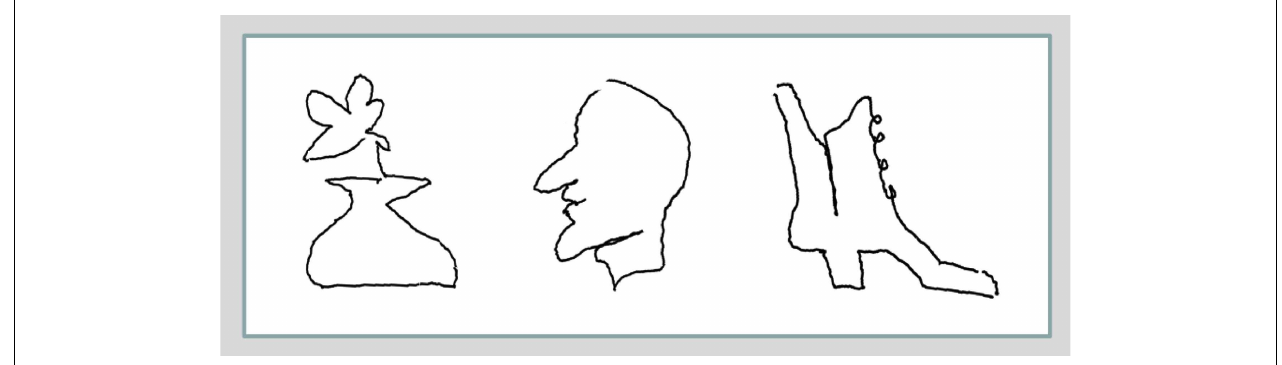
recorded in the scanner by the motion-capture system show a lot of specific detail, which makes them readily recognizable as specific examples of their category, although they were drawn without visual or tactile input (i.e., with eye-hand coordination eliminated), but were guided solely by